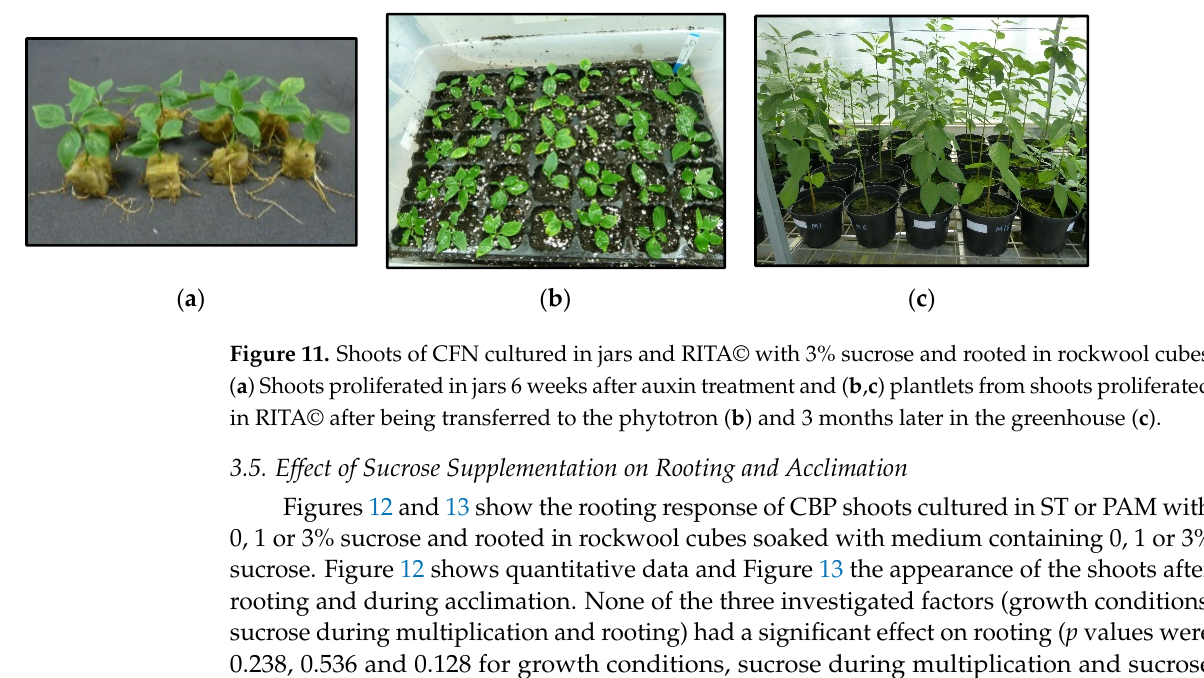
Figure 10. Shoots of CBP cultured in jars and RITA© with 3% sucrose and rooted in jars. ( a ) Shoots proliferated in jars 6 weeks after auxin treatment and ( b , c ) shoots proliferated in RITA© (6 immer- sions/day) 12 weeks after auxin treatment.